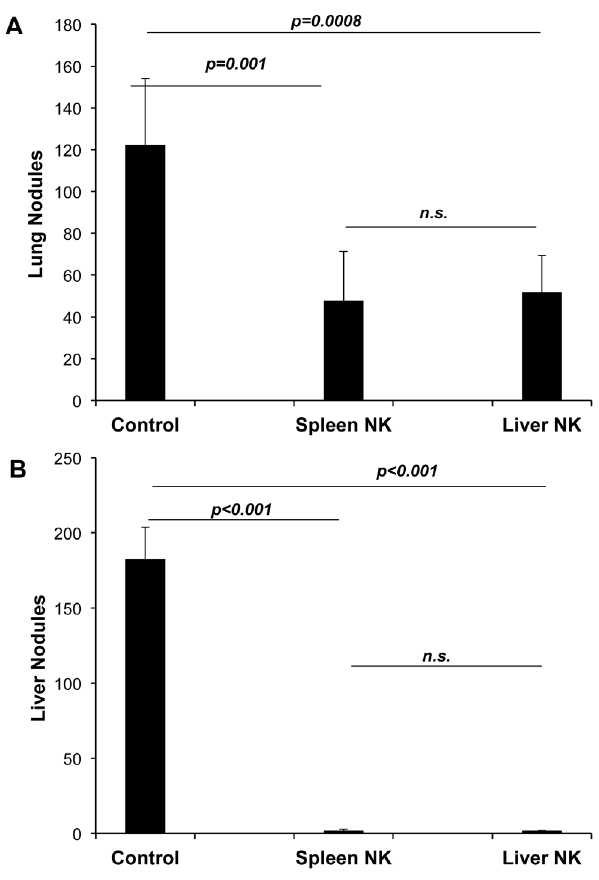
Figure 6. Adoptive transfer of NK cells protects NK cell deficient mice from tumor establishment. c c/RAG2 mice were injected i.v. with 2 6 10 5 sort-purified NK cells from the spleens or livers of wild-type C57BL/6 mice. Two weeks later, recipients were inoculated intravenously with 2 6 10 5 melanoma cells. Fourteen days later lungs and livers were excised and tumors enumerated. Six recipients were used per group.